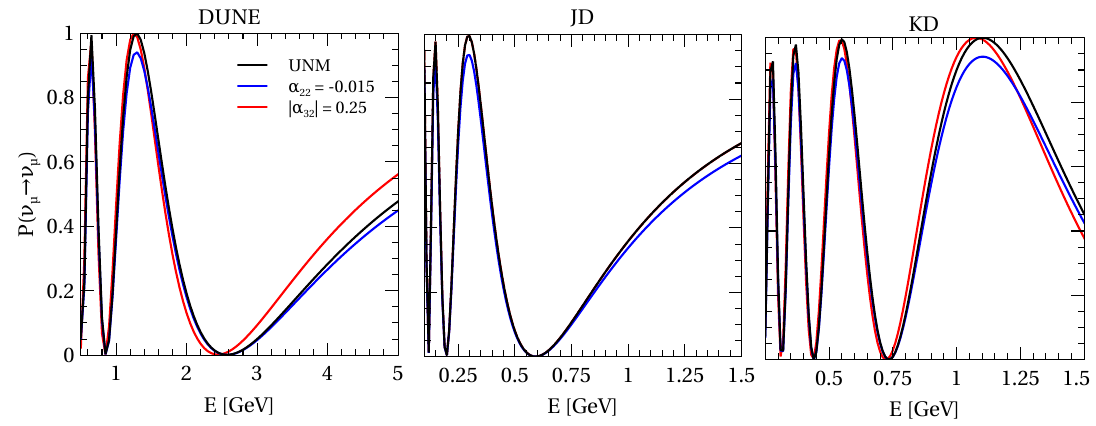
Figure 2 . ν µ → ν µ disappearance probabilities as a function of neutrino energy in the presence of the NUNM parameters α and | α assuming φ = 0 one at a time. Left, middle, and 22 32 | 32 right columns correspond to the baselines of 1300 km (DUNE), 295 km (JD), and 1100 km (KD), respectively. We consider δ = 0 ◦ and sin 2 θ = 0 . 5 . The values of the other oscillation parameters CP 23 are taken from table